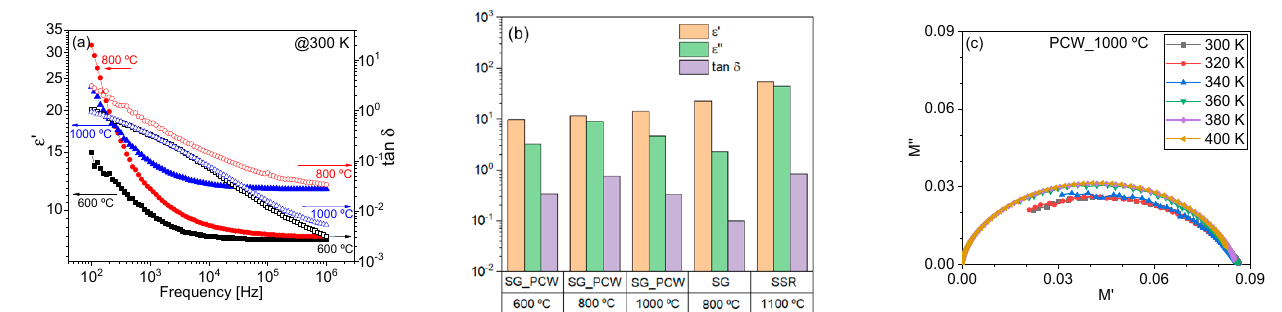
Figure 8. ( a ) Dielectric constant ( ε ’) and dielectric loss ( tan δ ) for all samples; ( b ) Comparison of LiFe 5 O 8 synthesis by different methods: sol-gel (proteic (SG_PCW) and Pechini (SG) routes) and solid-state reaction (SSR); ( c ) Nyquist plot of the sample heat-treated at 1000 °C, at temperatures from 300 to 400 K.